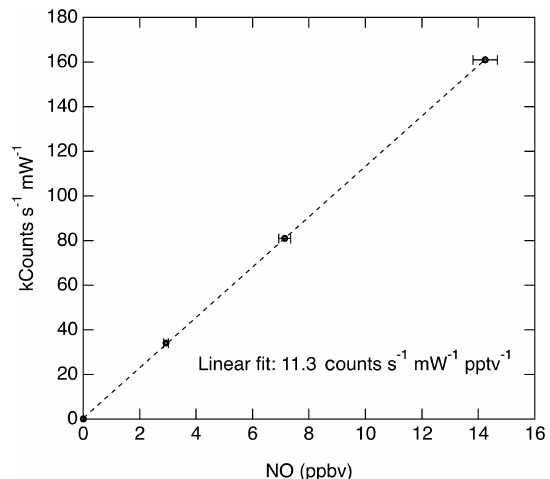
Figure 10. Typical calibration data acquired during a flight when sampling a mixture of NO in zero air. Error bars indicate the 1 σ uncertainty in the NO mixing ratio delivered. Statistical uncertainty in the observed signal at each point is < 0 .